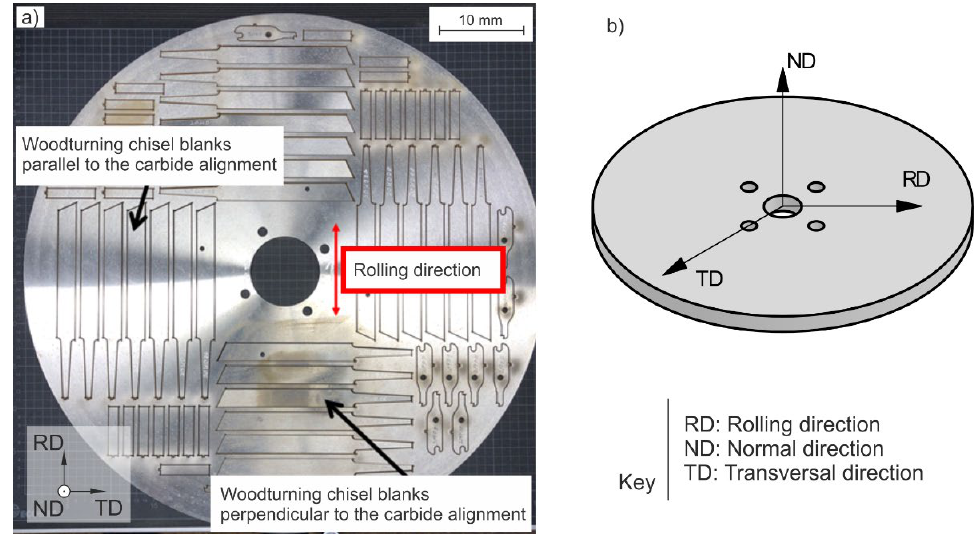
Figure 1. ( a ) Worn-out machine circular knife with repurposed chisel blanks, taken out in the rolling and transversal directions (RD, TD, respectively). ( b ) Schematic diagram of the axes system selected. The blanks were then manufactured into ready-to-use chisel shapes “A 20” according to this shape. The repurposed chisels were made of the cold work steel D2, and the bench-